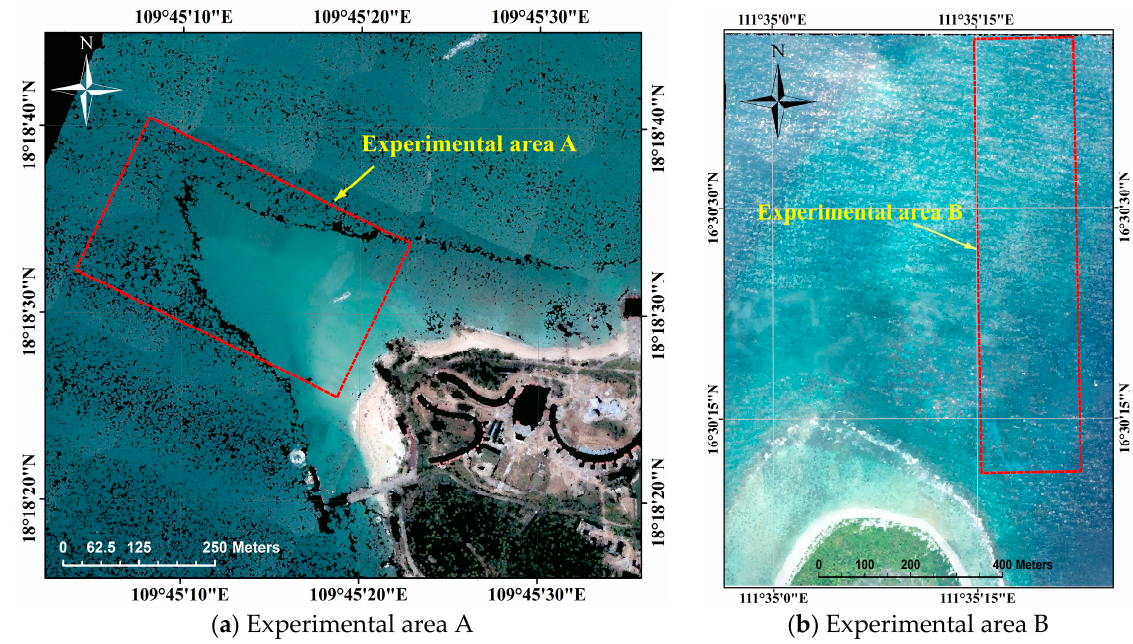
Figure 1. The area point-cloud after real color rendering and the experimental areas.